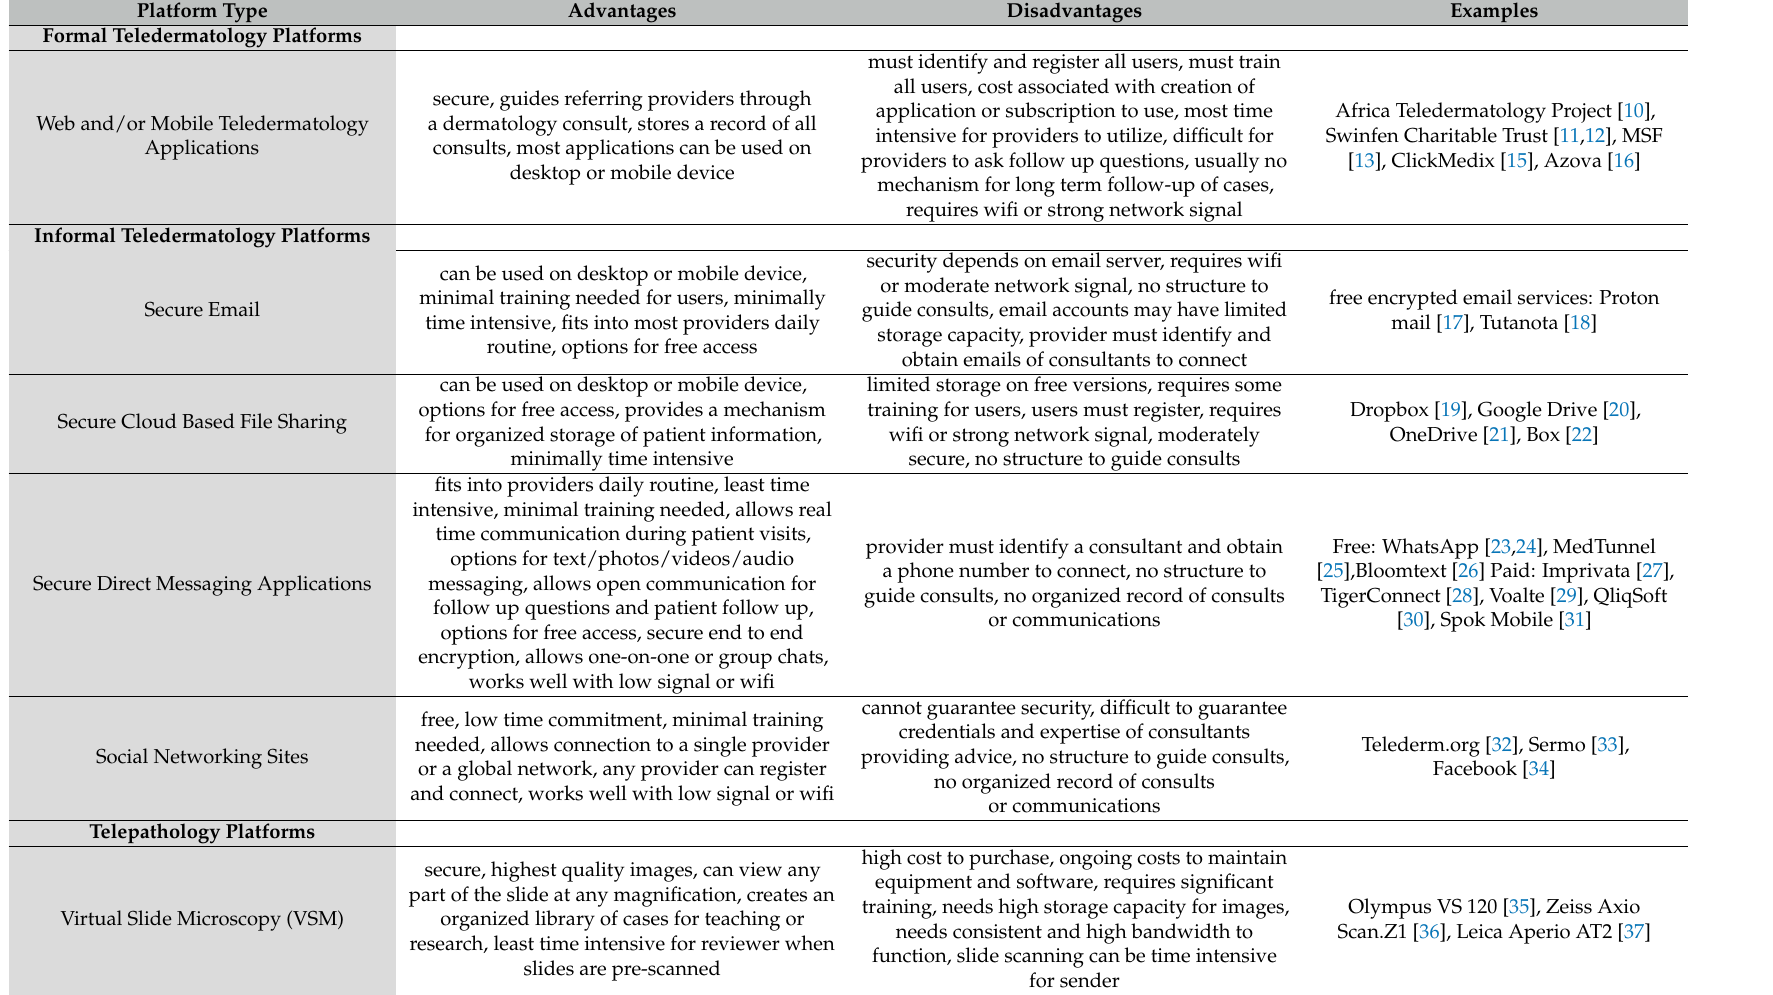
Table 1. Description of teledermatology and telepathology platform types, advantages, disadvantages and